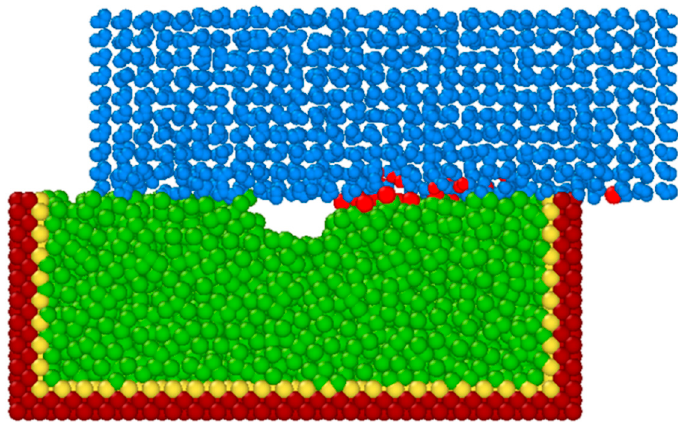
Figure 18. MD Simulation Snapshot Showing Formation of Cavities Leading to Bubble Formation during LA-LBMM Process in Dynamic Mode.